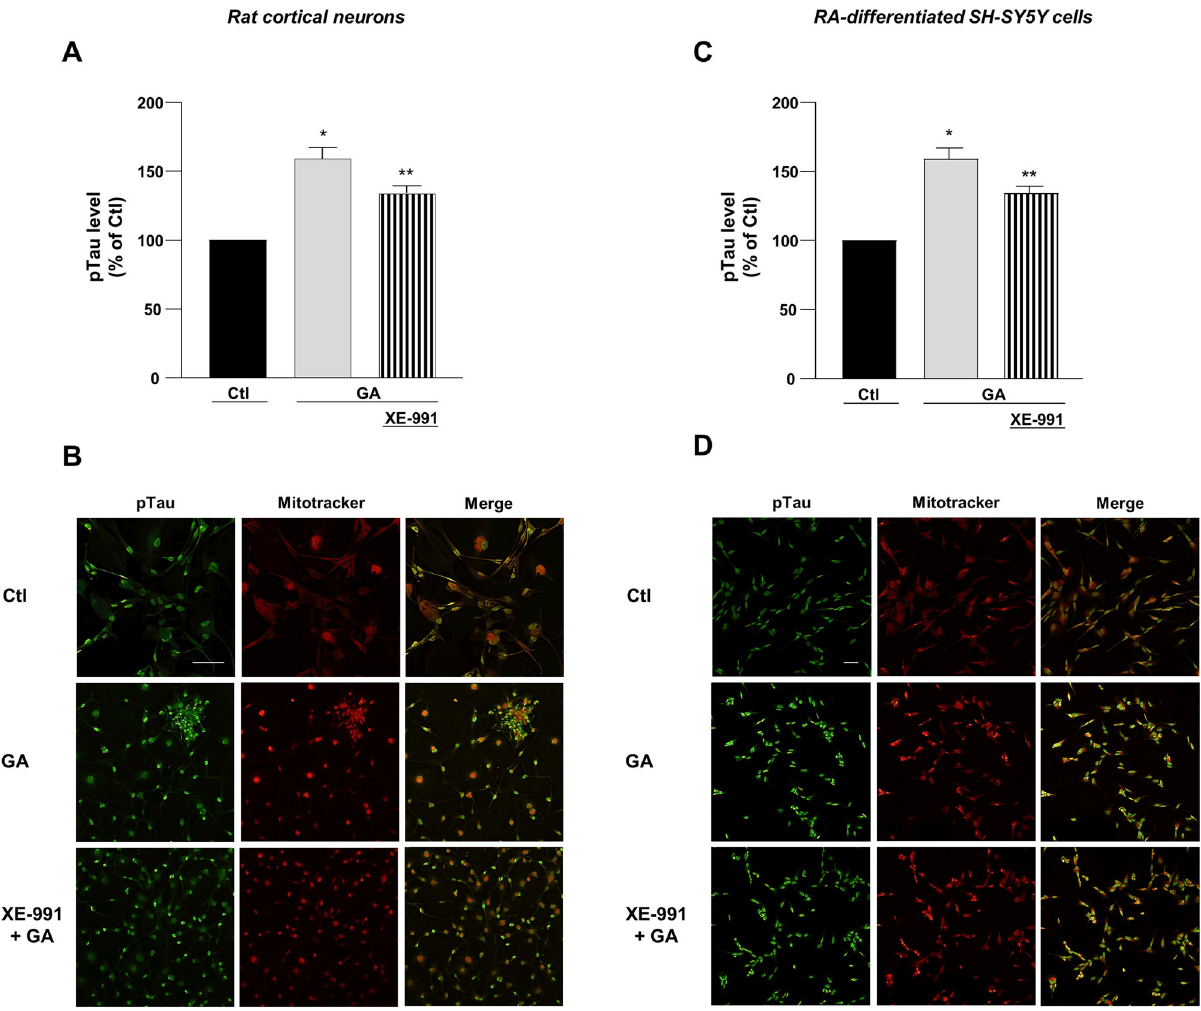
Fig. 6 pTau expression in primary rat cortical neurons and RA-differentiated SH-SY5Y cells treated with GA and exposed to XE-991. A , C Quanti fi cation and B , D representative pictures of pTau expression. pTau was identi fi ed by immuno fl uorescence staining ( A – D ). Scale bar 50 µM. The intensity of fl uorescence of pTau was reported as control percentage. Differences among means were evaluated by one-way ANOVA followed by Dunnett ’ s post hoc test. A F (2, 6) = 26.96. Each column depicts the mean ± S.E.M. of independent experiments (for each experimental group, 50 – 100 cells were analyzed). *Signi fi cant versus all groups ( p < 0.0001 versus Ctl, p < 0.01 versus XE-991 + GA); **signi fi cant versus all groups ( p < 0.01). C F (2, 12) = 43.43. Each column depicts the mean ± S.E.M. of fi ve independent experiments (for each experimental group, 50 – 100 cells were analyzed). *Signi fi cant versus Ctl ( p < 0.0001) and XE-991 + GA ( p < 0.01); **signi fi cant versus Ctl ( p < 0.001) and GA ( p <